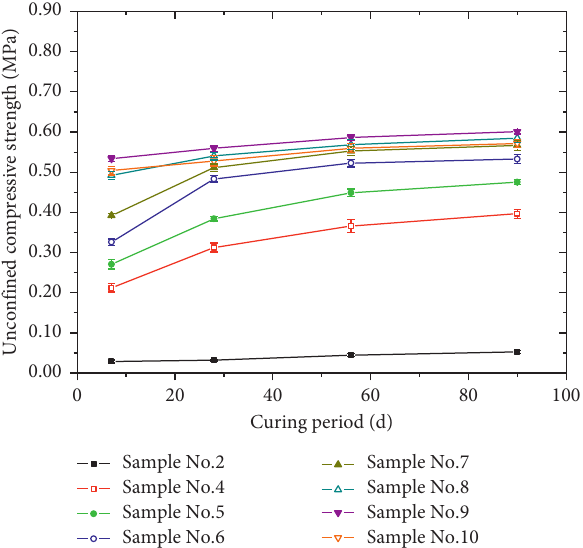
Figure 8: Influence of curing period on UCS of samples stabilised with Ca(OH)